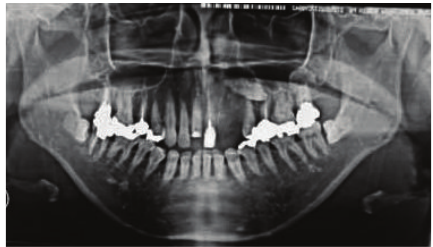
Figure 3: Panoramic radiograph showing horizontally embedded canine of the left maxilla.